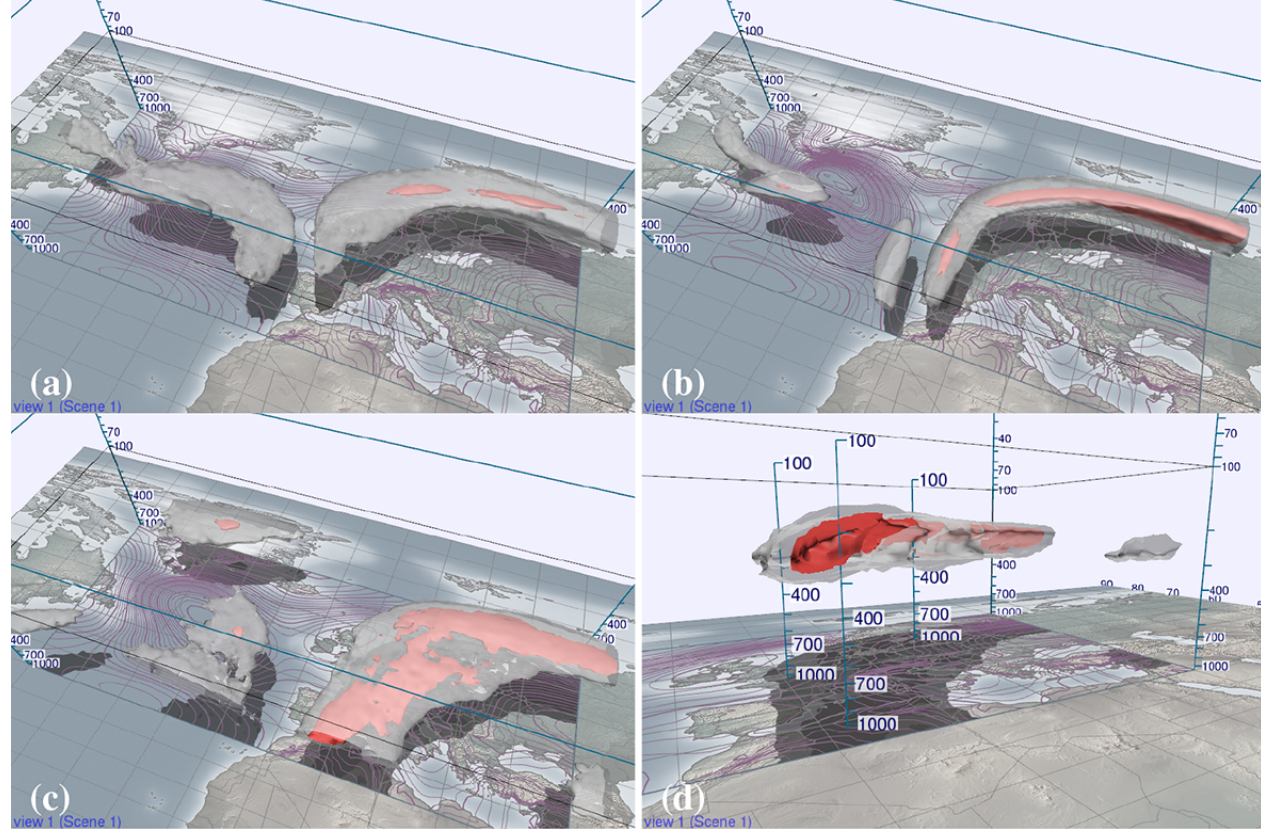
Figure 7. Probability fields computed from the ensemble, valid at 18:00UTC, 19 October 2012. ( a and b ) Probability of horizontal wind speed exceeding 50ms − 1 , as computed from the forecast initialized (a) at 00:00UTC, 15 October 2012 and (b) at 00:00UTC, 17 October 2012. Shown are the 70% (red opaque) and 10% (white transparent) isosurfaces. Note how the ensemble converges. ( c and d ) Probability of contrail occurrence (Schmidt–Appleman criterion fulfilled and relative humidity greater than 80%), as viewed from different camera positions (80% red opaque and 50% white transparent) (animated version of this figure in the Supplement at